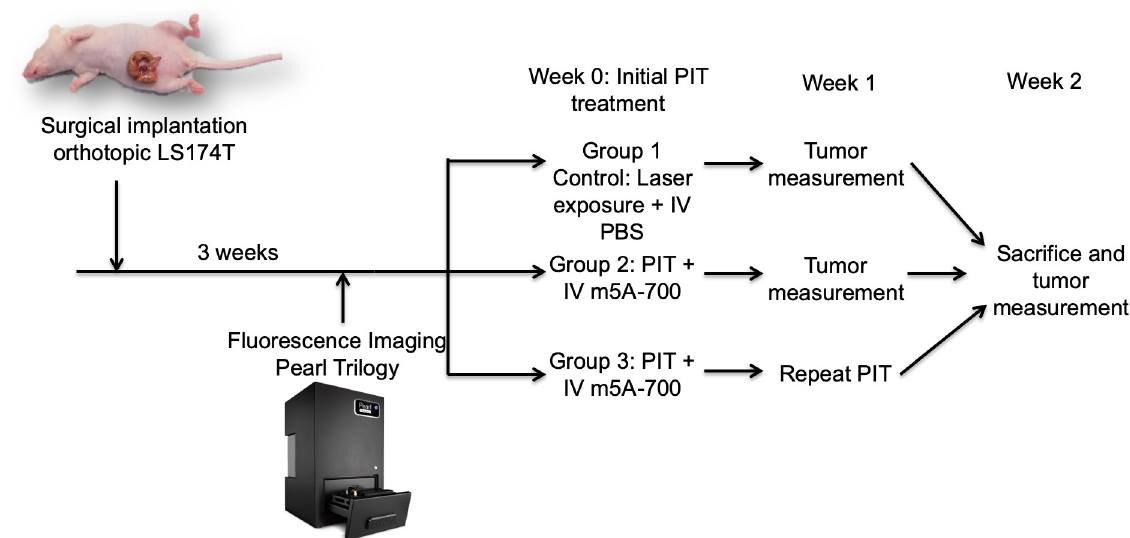
Fig 1. Experimental protocol. Surgical implantation of an LS174T tumor fragment (1 mm 3 ) onto the cecum was initially performed. Tumors grew 3 weeks and then were imaged with the Pearl Trilogy Small Animal Imaging System. At week 0, initial PIT treatment was performed. At week 1, group 3 received repeat PIT and tumors were measured with calipers. At week 2, mice were sacrificed and tumor size measured.